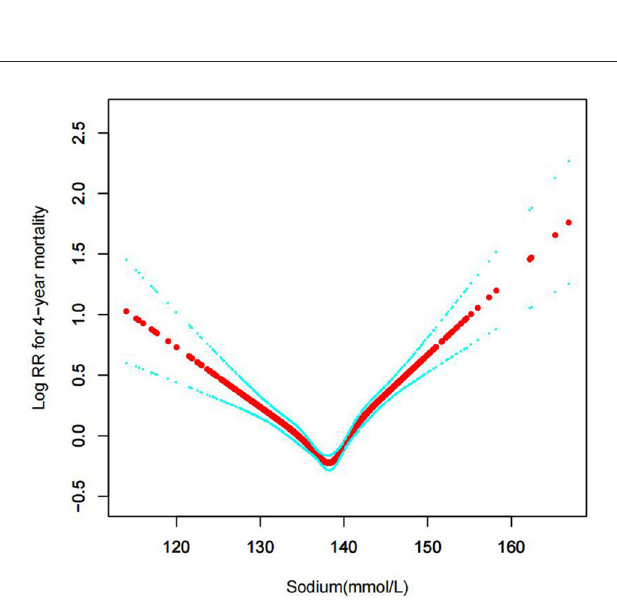
FIGURE4 Association between serum sodium levels and 90-day all-cause mortality (Unadjusted model).